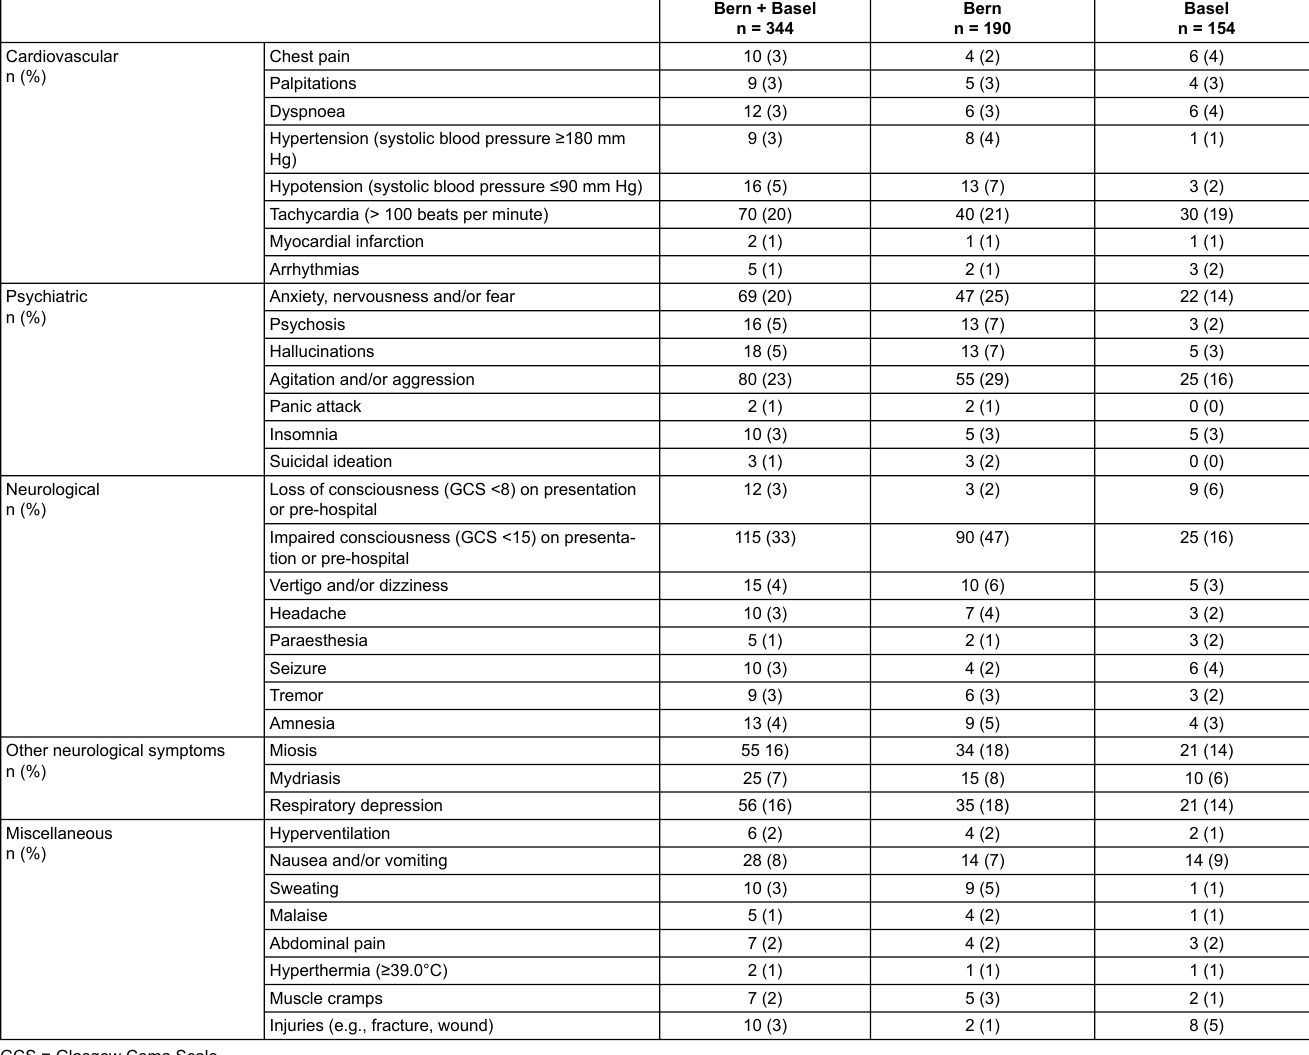
Table 3: Clinical presentations in Bern and Basel.